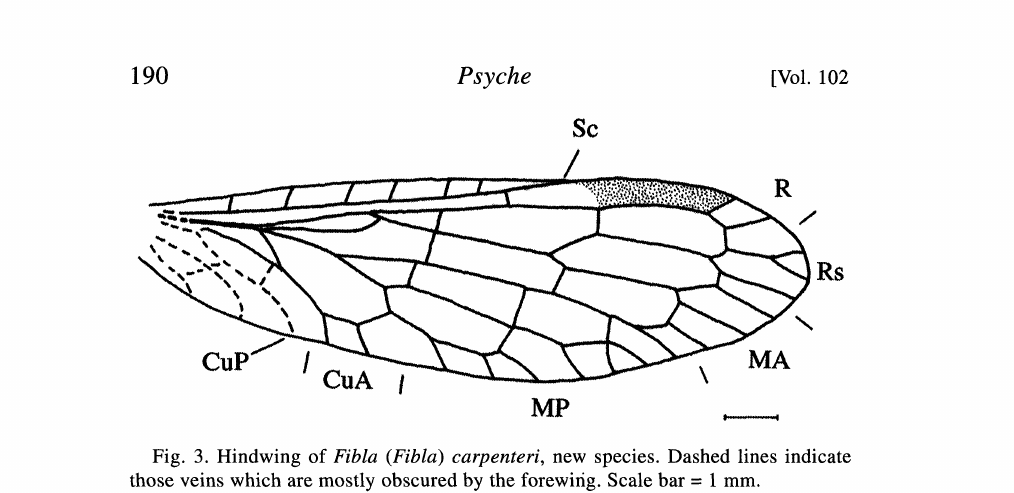
Fig. 3. Hindwing of Fibla (Fibla) carpenteri, new species. Dashed lines indicate those veins which are mostly obscured by the forewirig. Scale bar